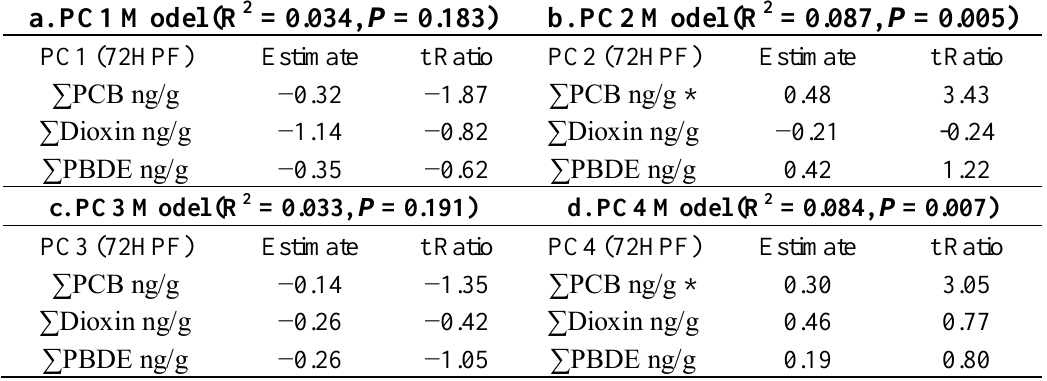
Table 4. Standard least squares multiple linear regression effects for 72 h post-fertilization principle components. Model parameters are ng/g sediment of: total PBDEs congeners, total PCB congeners, and total Dioxins. All sediment contaminant values were log transformed. T-Ratio is the ratio of the estimate to its standard